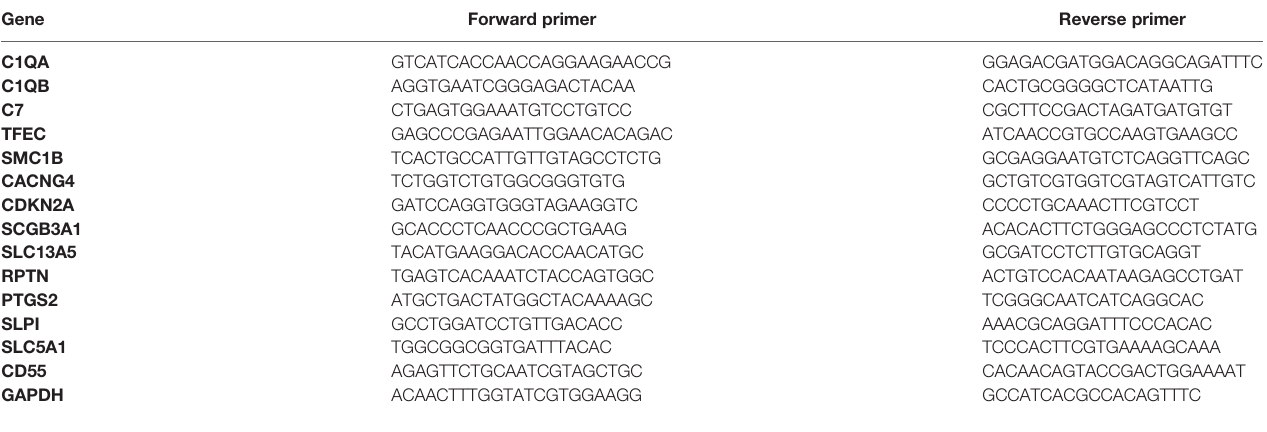
TABLE 1 | Sequences of RT-PCR primers used for